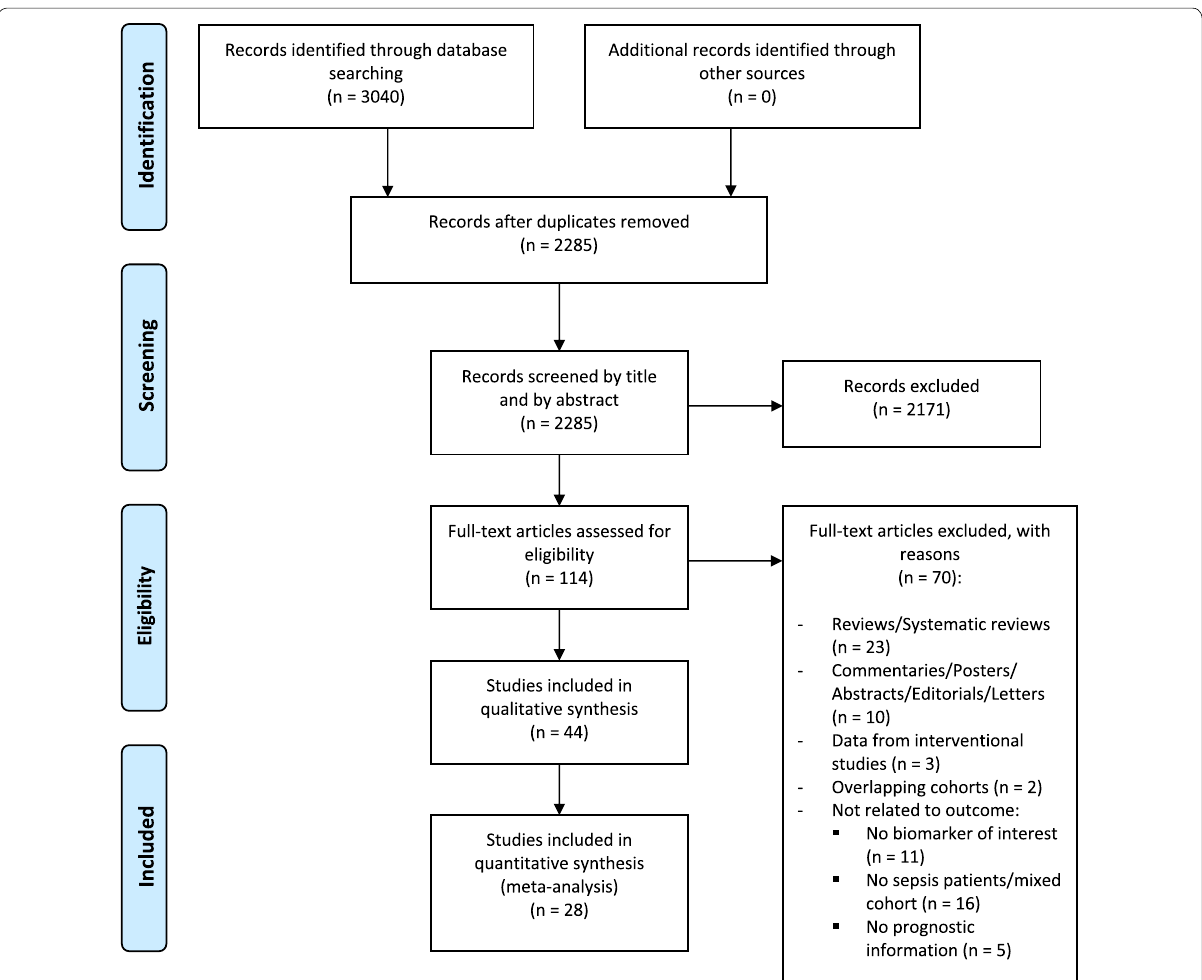
Fig. 1 PRISMA flow diagram of study